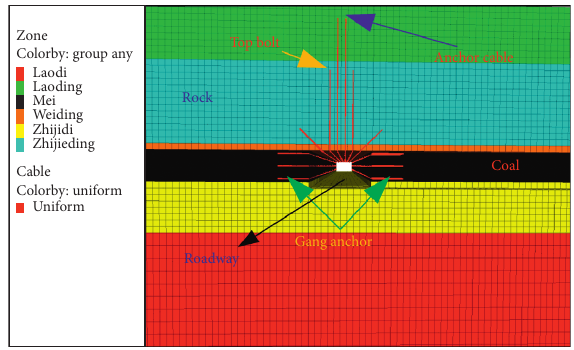
Figure 2: Experimental simulation